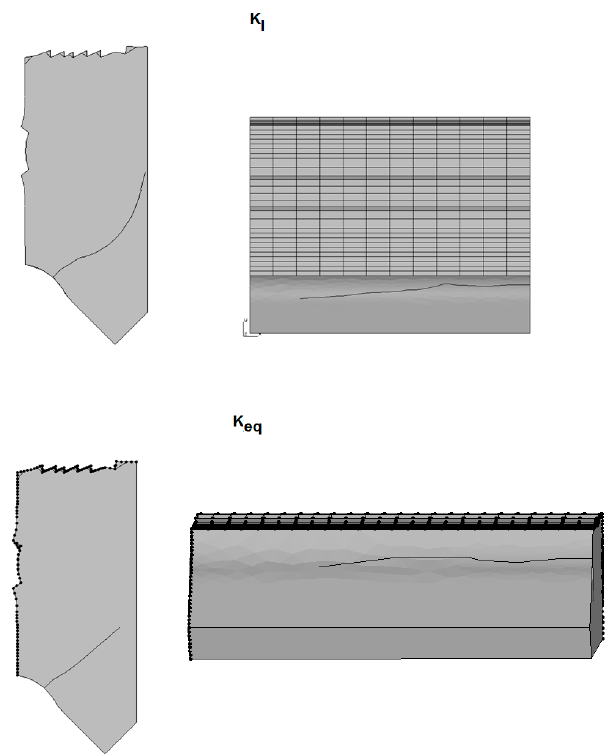
Figure 28. Crack shape and direction, a direct comparison between K I and K eq . The geometry is a 45° short flank.